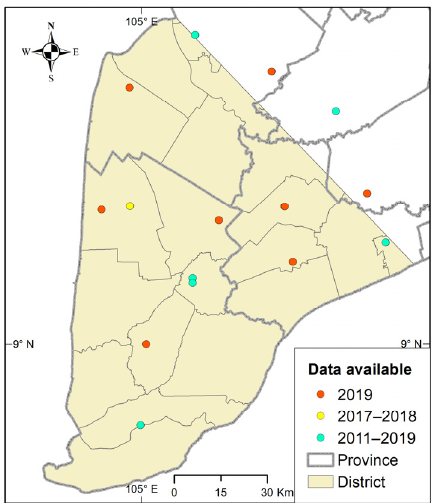
Figure 3. Observation well availability from 2011 to 2019 (source: NAWAPI [21]).